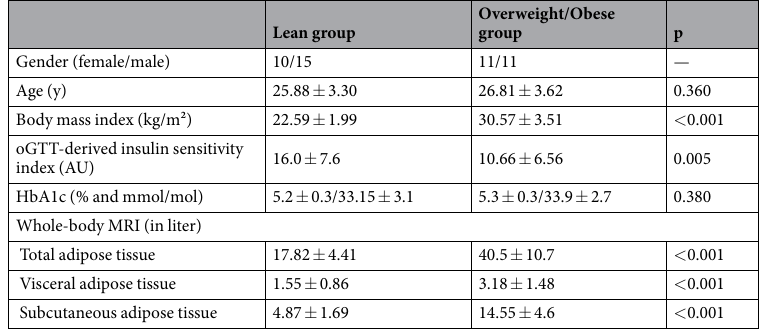
Table 1. Participants’ characteristics. Data are presented as mean ± SD. P = P-values for comparison of unadjusted log e -transformed data by